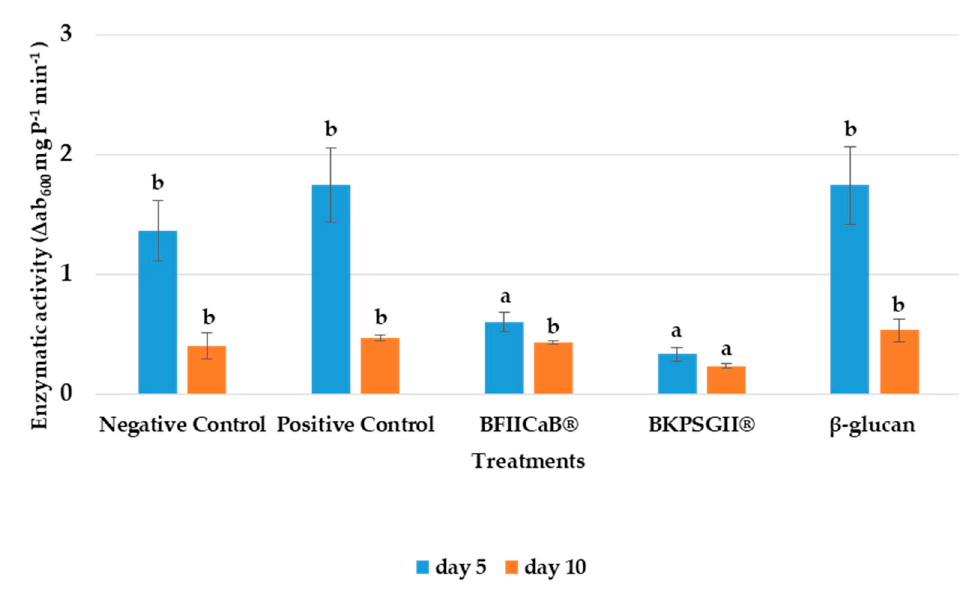
Figure 4. Phenylalanine ammonia lyase (PAL) activity in tomato induced by the different treatments were evaluated 5 and 10 DAI with FOL. Plants were treated with distilled water (negative control), Serenade ® (positive control), β -glucan, BFIICaB ® and BKPSGII ® . a , b : Equal letters indicate no significant differences at the p -value < 0.05. The statistical analysis was performed separately for each time interval after treatment (average ± SD; n = 3).